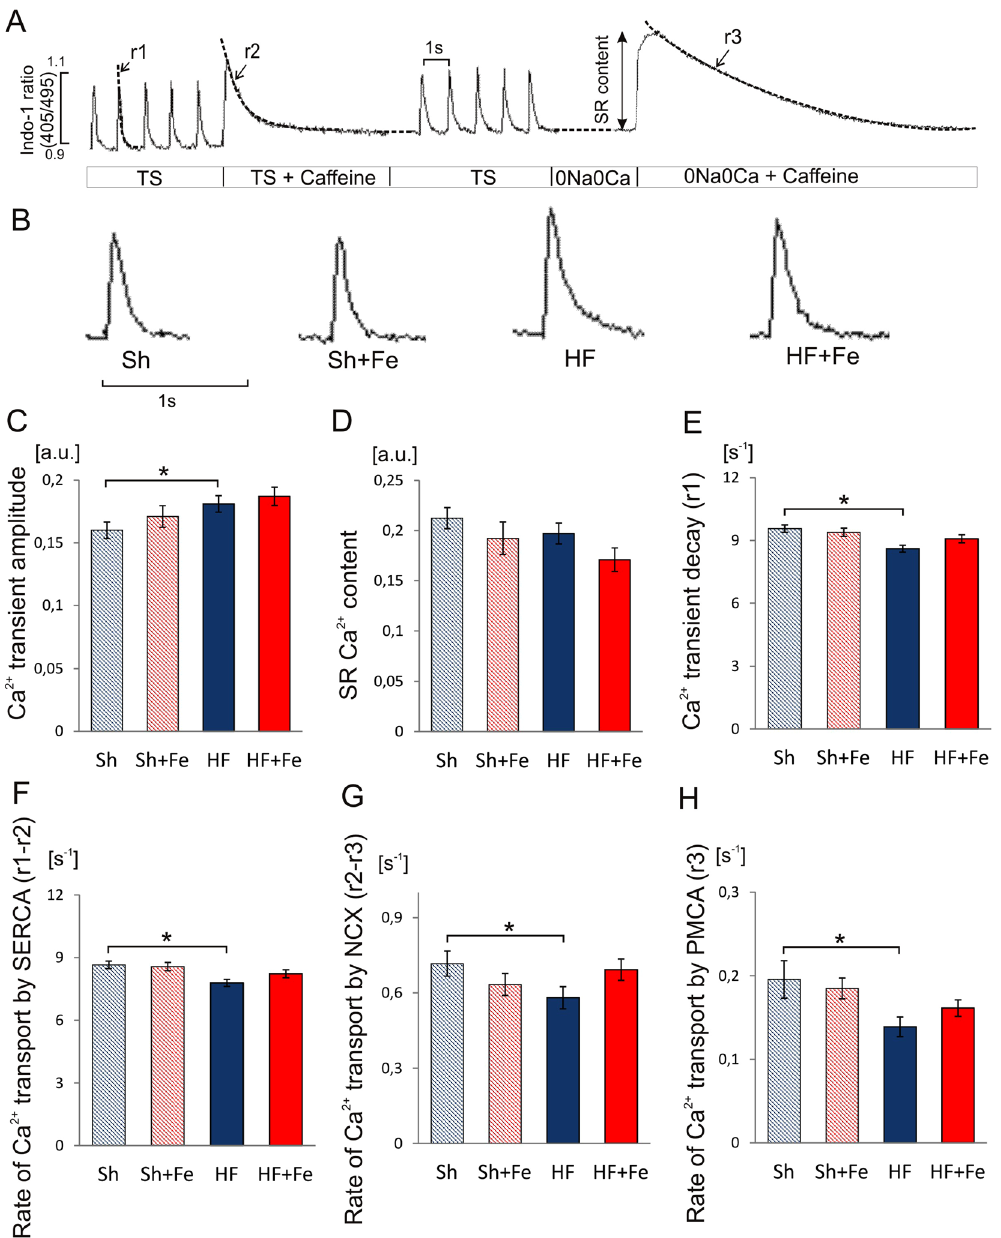
Figure 5. The effect of intravenous iron (Fe) supplementation on the Ca 2 + handling parameters in cardiomyocytes isolated from sham operated (Sh) and heart failure (HF) rats. ( A ) Experimental protocol: cardiomyocytes were stimulated at 1 Hz. Caffeine was applied to cardiomyocytes superfused with Tyrode solution (TS) or Na + /Ca 2 + free solution (0Na0Ca). Single exponential curves were fitted to decaying part of electrically- or caffeine-evoked Ca 2 + transients and rate constants of their decay (r1, r2 and r3) were calculated. The rate of Ca 2 + transport by SERCA, NCX and PMCA was calculated according to formulas: r SERCA = r1 − r2, r NCX = r2 − r3 and r PMCA = r3, respectively. ( B ) representative Ca 2 + transients recording for each experimental group; ( C ) amplitude of Ca 2 + transient; ( D ) sarcoplasmic reticulum (SR) Ca 2 + content; ( E ) rate of Ca 2 + transient decay (r1); ( F – H ) rate of Ca 2 + transport by SERCA (r1 − r2), NCX (r2 − r3) and PMCA (r3), respectively. Data is represented as mean ± SEM, n = 12–31 cardiomyocytes/group isolated from 5 hearts in each group, * p < 0.05, only statistically significant differences were